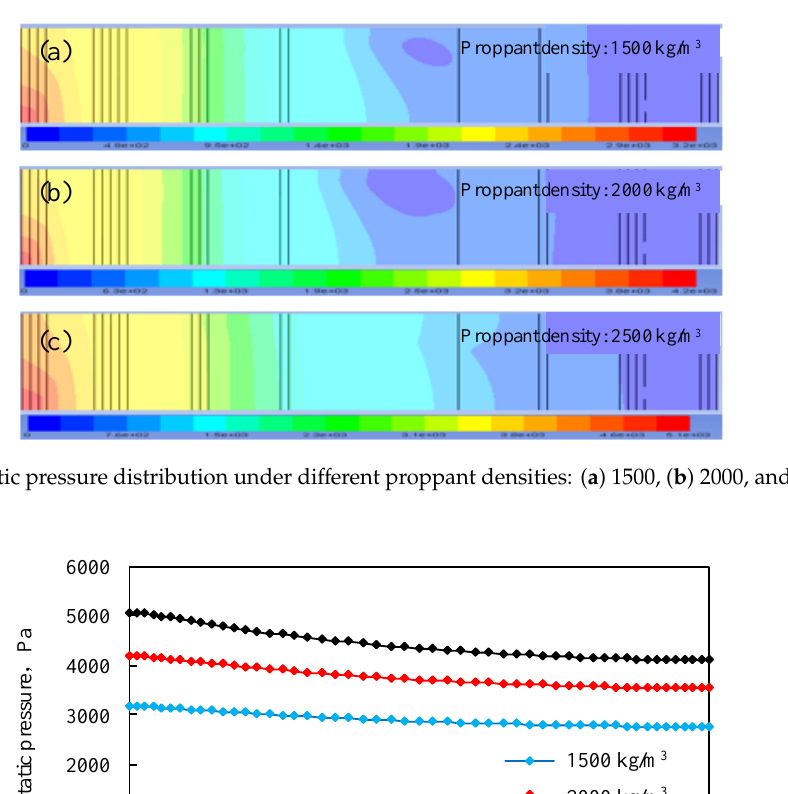
Figure 8. Static pressure distribution at 0.2 m after fracture inlet.